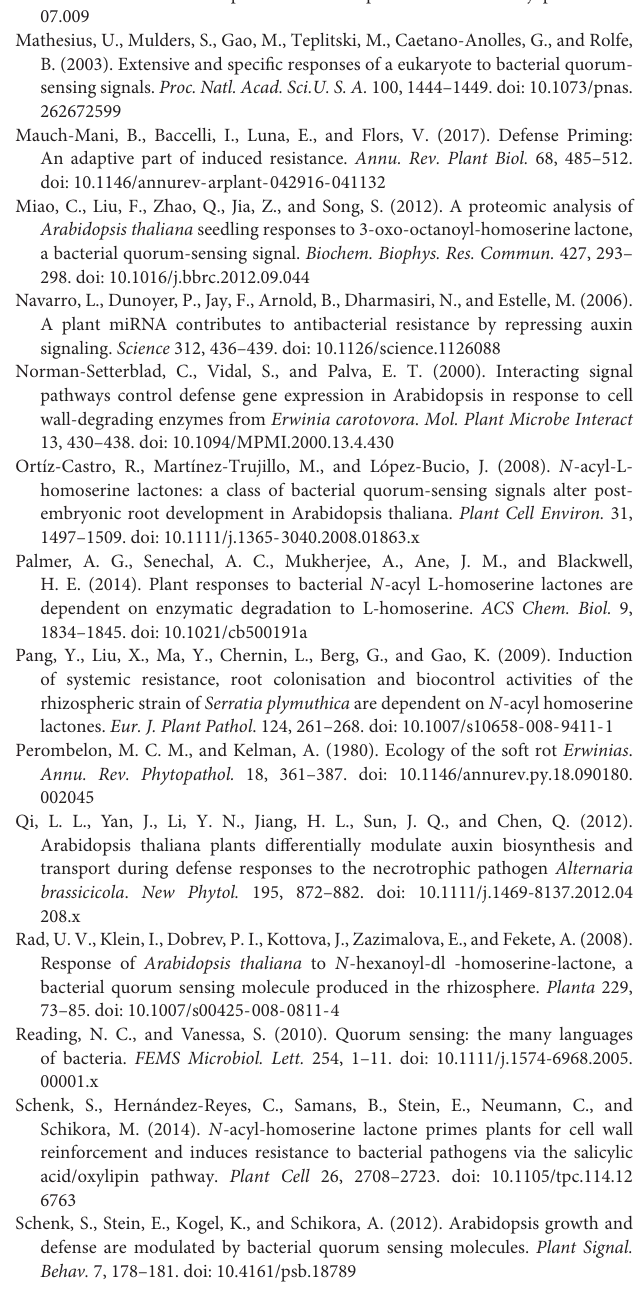
were subsequently spray-inoculated with 10 7 CFU/mL Pcc . The experiments were performed at least three independent experiments with three technical repeats. Asterisks indicate a statistically significant difference between the AHL-pretreated and the water-treated plants (ANOVA test, * P < 0.05). Values are means ± SD of three independent experiments. Supplementary Figure 3 | AHL induced expression GUS in DR5::GUS plant. The experiments were performed at least five independent experiments with three technical repeats. Asterisks indicate a statistically significant difference between the AHL-pretreated and the water-treated plants (ANOVA test, * P < 0.05). Values are means ± SD of five independent